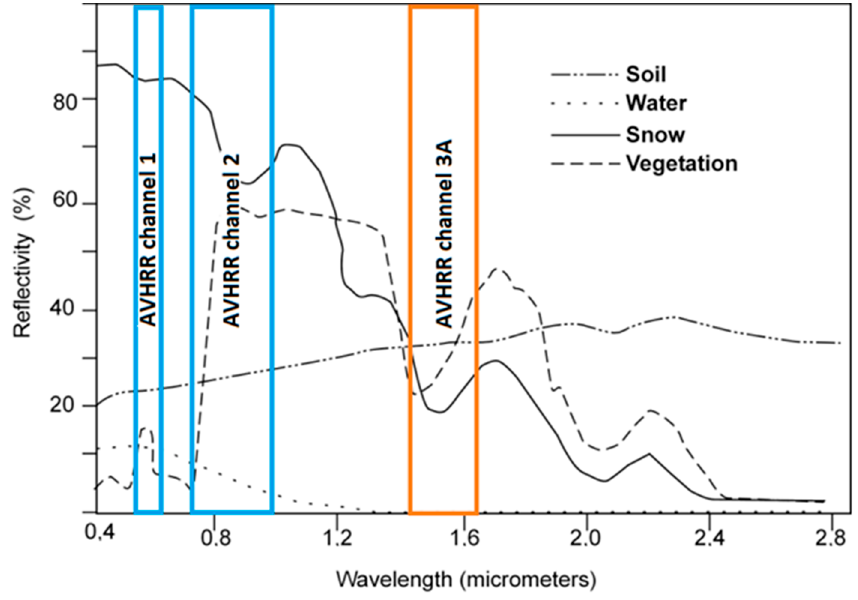
Figure 4. Reflectance properties of water compared to other land cover types. AVHRR bandwidths are highlighted, with channels 1 and 2 being available for all AVHRR sensors and channel 3A only available for AVHRR generation 3, as well as Metop-A and -B.